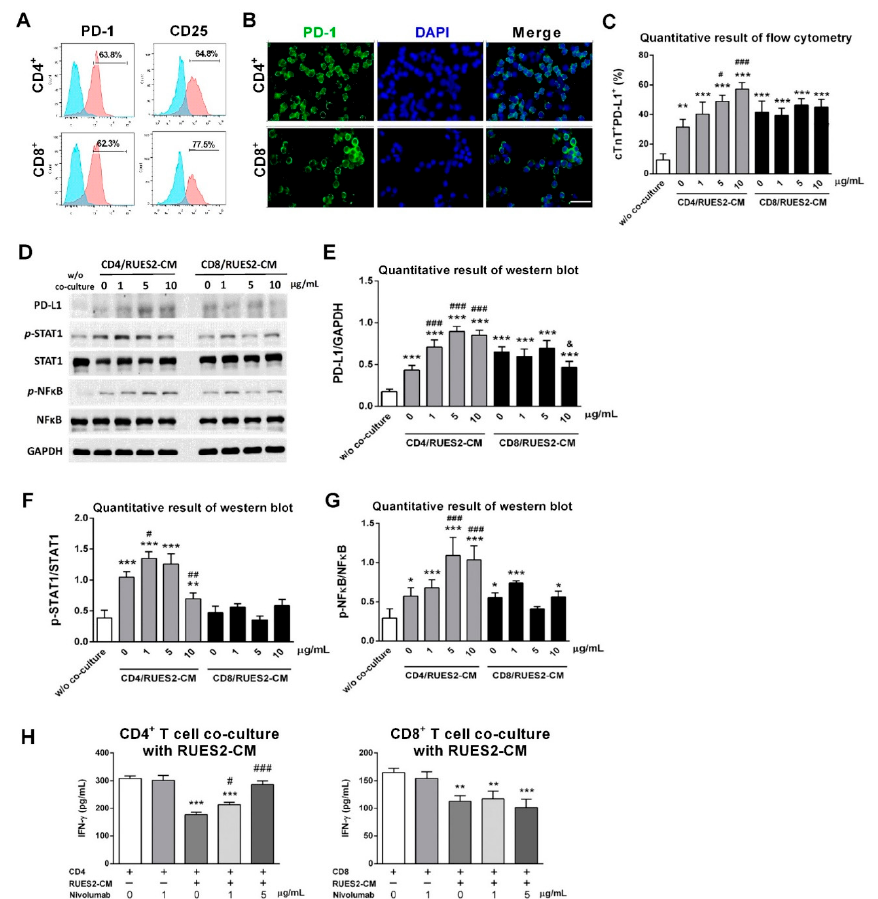
Figure 3. Validation of PD-1 expression on CD4 + and CD8 + T lymphocytes. ( A ) Representative flow cytometry results of PD-1 and activation marker CD25 expression on CD4 + and CD8 + T lymphocytes after anti-CD3 / CD28 stimulation. PD-1, programmed death-1. ( B ) Representative micrographs showing immunostained PD-1 + cells (green) on the CD4 + and CD8 + T lymphocytes. Scale bar: 50 µm. ( C ) Quantification of cTnT + /PD-L1 expression by flow cytometry analysis of levels of cTnT + /PD-L1 expression on RUES2-CMs co-cultured with CD4 + and CD8 + T lymphocytes with nivolumab treatment at different doses. ** p < 0.01, *** p < 0.001 versus RUES2-CMs alone group; # p < 0.05, ### p < 0.001 versus CD4/RUES2-CMs human IgG4 isotype control (w/o co-culture) group ( n = 3). ( D ) Representative western blot analysis on RUES2-CMs co-cultured with CD4 + and CD8 + T lymphocytes containing nivolumab treatment with different doses and quantitative results ( E – G ). * p < 0.05, ** p < 0.01, *** p < 0.001 versus RUES2-CMs alone group; # p < 0.05, ## p < 0.01, ### p < 0.001 versus CD4/RUES2-CMs human IgG4 isotype control (w/o co-culture) group; & p < 0.05 versus CD8/RUES2-CMs human IgG4 isotype control (w/o co-culture) group ( n = 3), one-way ANOVA, posthoc Bonferroni test. ( H ) Quantitative result of ELISA assay, showing production of IFN- γ in CD4 + T lymphocytes/RUES2-CMs and CD8 + T lymphocytes/RUES2-CMs co-culture medium. ** p < 0.01, *** p < 0.001 versus CD4+ T lymphocytes alone group; # p < 0.05, ### p < 0.001 versus CD4/RUES2-CMs human IgG4 isotype control (w/o co-culture) group ( n = 3).